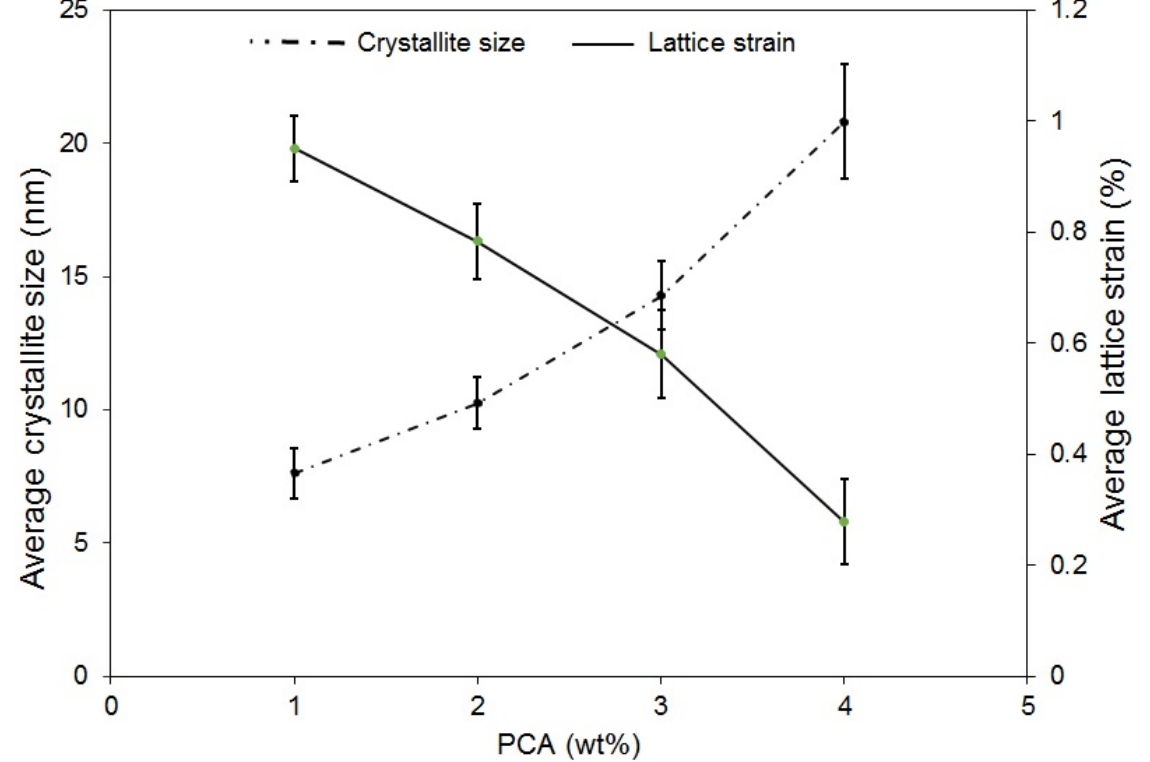
Figure 2. Variation in average crystallite size (nm) and lattice strain (%) of mechanically alloyed AlCrCuFeNi HEA after 60 h of milling as a function of PCA amount.